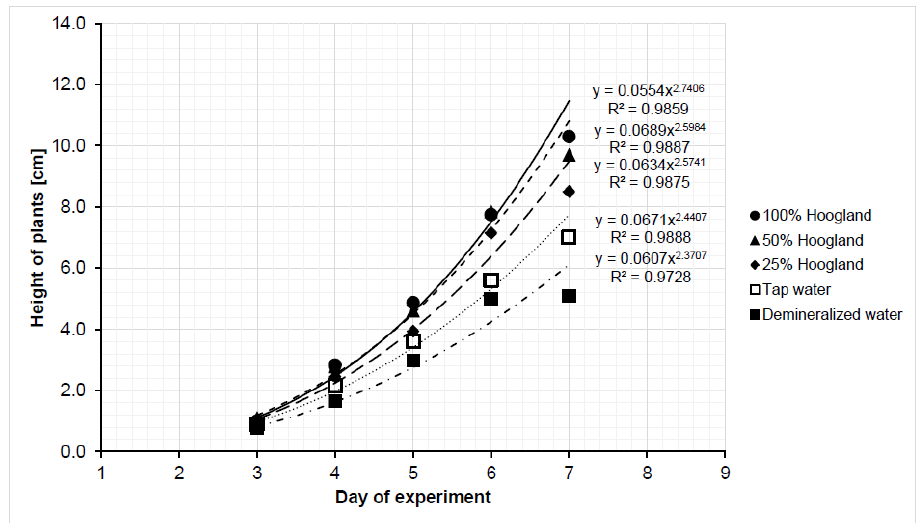
Figure 3. Average height growth of radish cress. A power function curve connects the data points of the graph. R 2 is the square of the correlation coefficient. Table 4. Estimated area of cotyledons of radish cress and stem length of garden and radish cress. Different letters within a column indicate significant